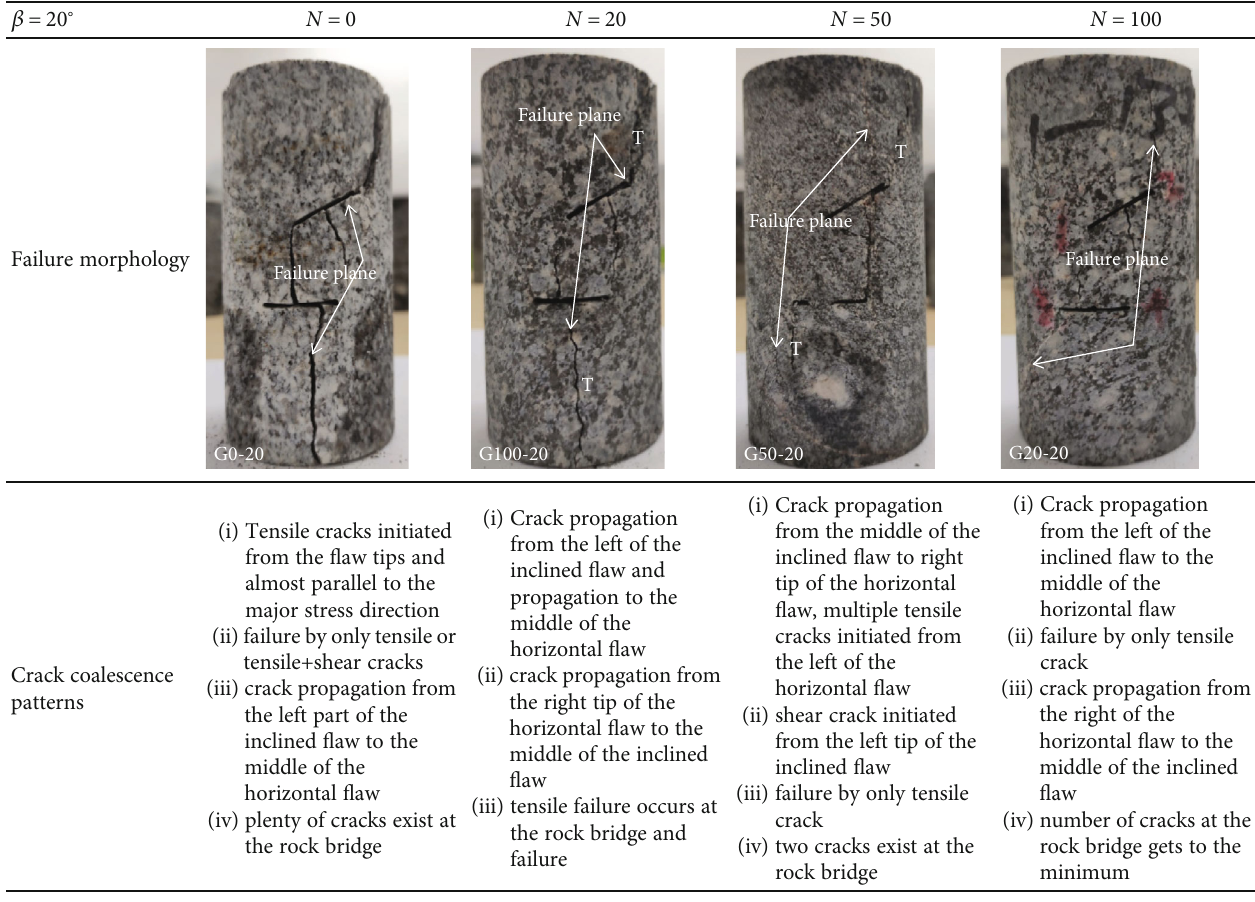
Table 2: Crack propagation and coalescence for the samples with an inclination fl aw of 20 °